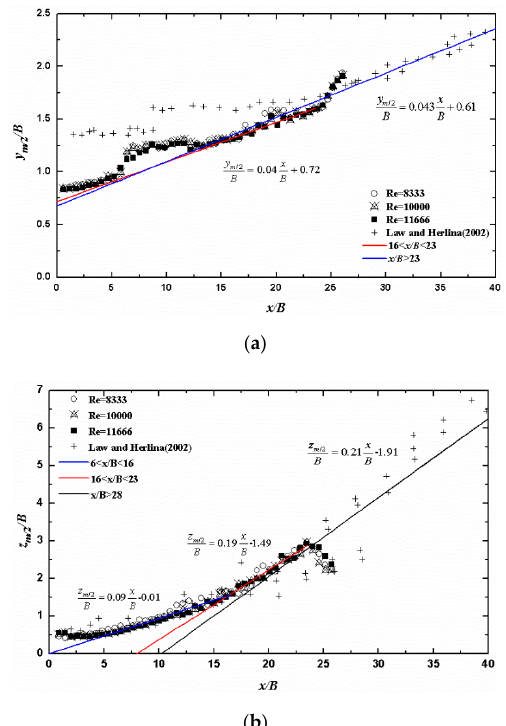
Figure 4. Mean flow developments of the 3D confined wall jet with Re = 8333, 10,000 and 11,666: ( a ) velocity half-height y m/2 , and ( b ) velocity half-width z m/2.